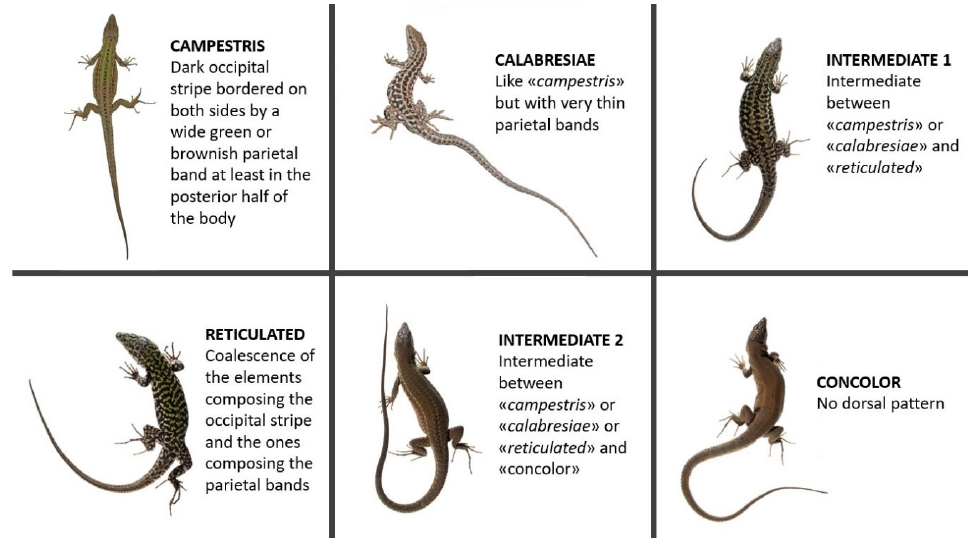
Figure 2. The six main DP categories found in the Tuscan Archipelago. Picture for “campestris” by